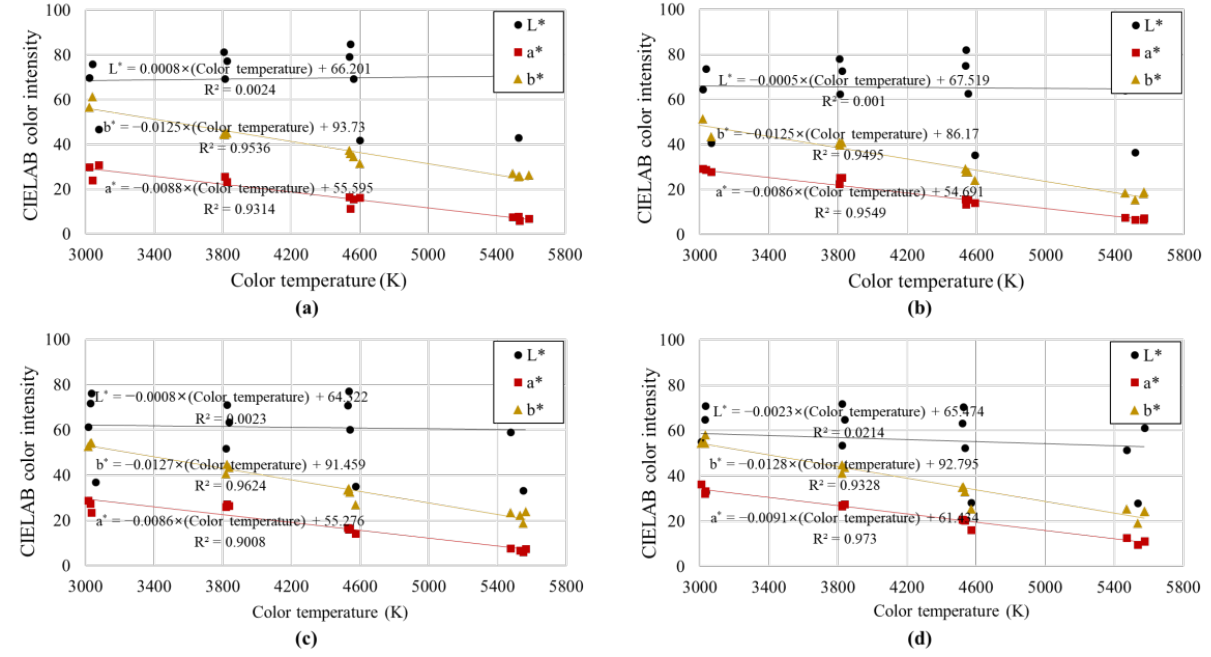
Figure 11. Mode CIELAB color intensities according to the color temperature of light: ( a ) Jumunjin sand, ( b ) Anseong soil, ( c ) Yongin soil, and ( d ) Gwanak soil.